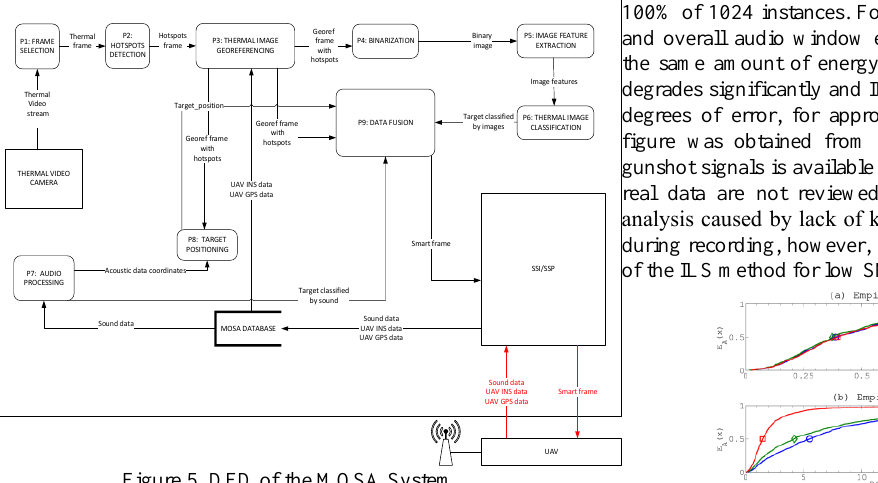
Figure 6: (Color online) Empirical CDF of error at (a) SNR=15 dB and (b) SNR=0 dB. E A (x) is the empirical CDF of error of algorithm A. For picture clarity, the curves may not include the highest 2% sampled errors. Reproduced with permission from (Freire, 2014b). Copyright 2014, Acoustical Society of